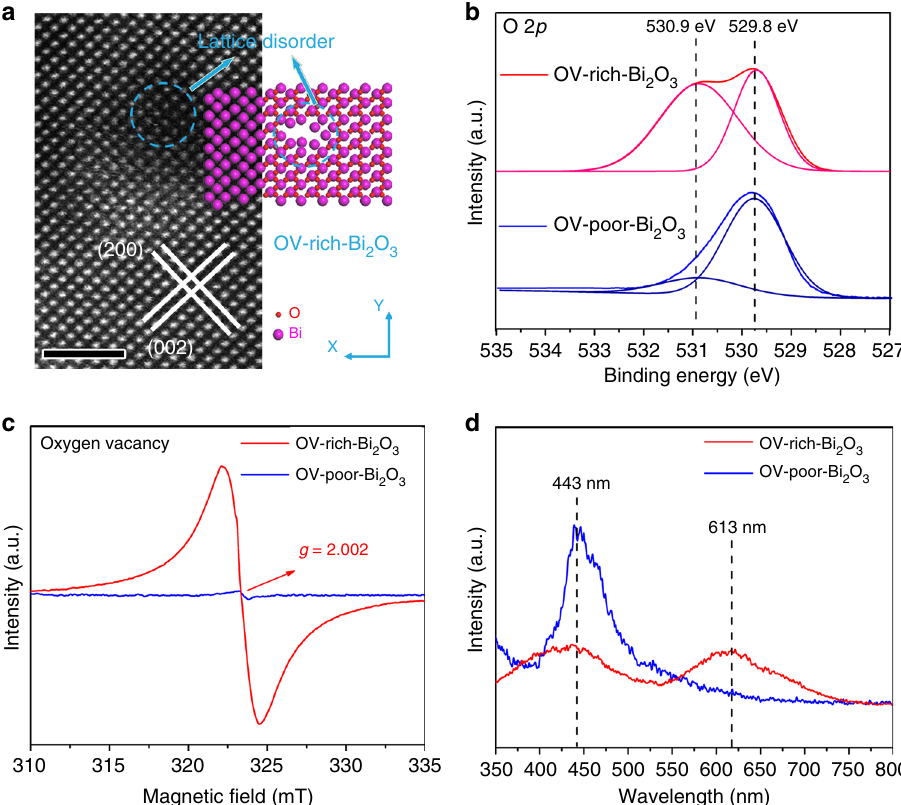
Fig. 3 Structure characterizations for the defect-controlled Bi 2 O 3 nanosheets. a Atomic-resolution HAADF-STEM images and corresponding structure model of OV-rich-Bi 2 O 3 nanosheets. The scale bar is 2 nm. b O 2 p XPS spectra, c Room-temperature ESR spectra, and d PL spectra of Bi 2 O 3 nanosheets with rich and poor oxygen vacancies,